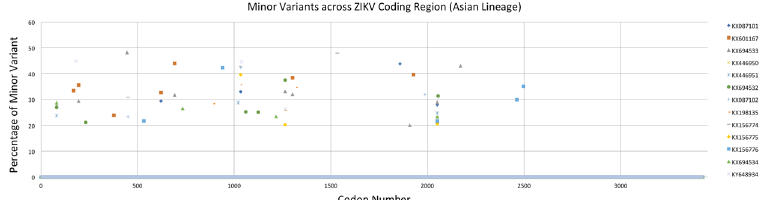
Figure 2. Positions of minor variants detected in Asian-lineage Zika viruses. The location of codons containing minor variants in strains belonging to the Asian lineage with the frequency threshold set at 20% (or more) of reads.